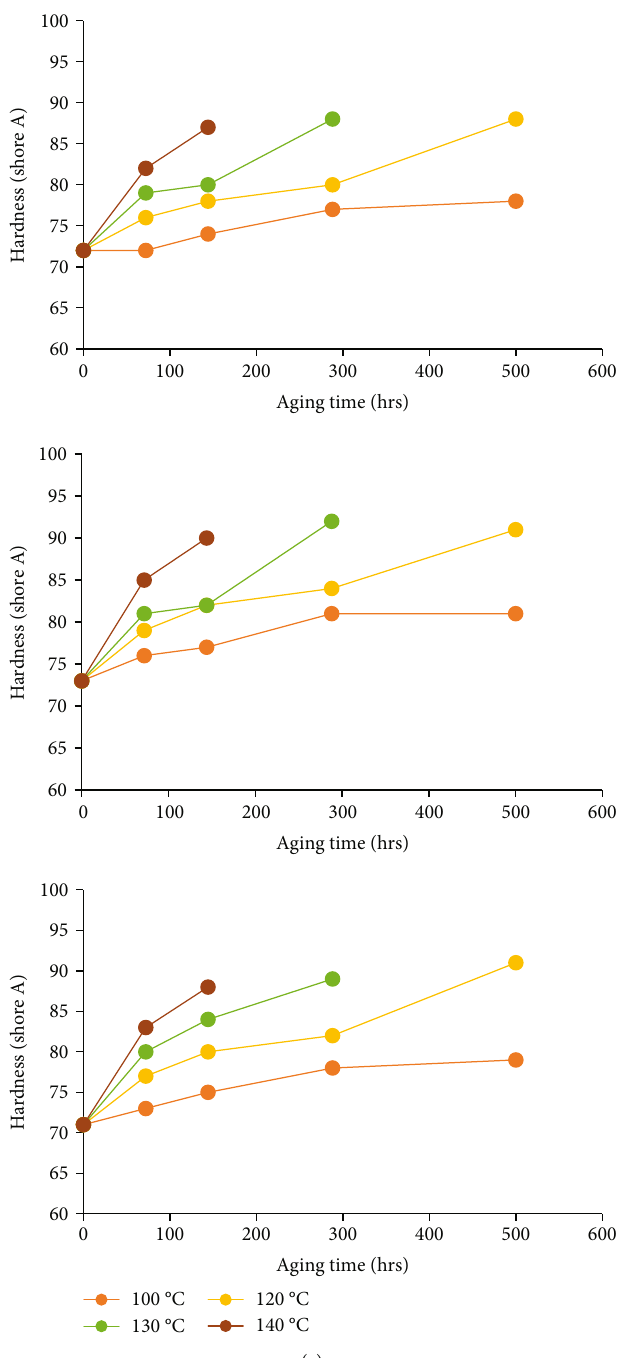
Figure 8: E ff ect of thermal aging on (a) tensile strength, (b) elongation at break, and (c) hardness of vulcanizates of acrylonitrile-chloroprene rubber (NCR), chloroprene rubber (CR), and nitrile rubber